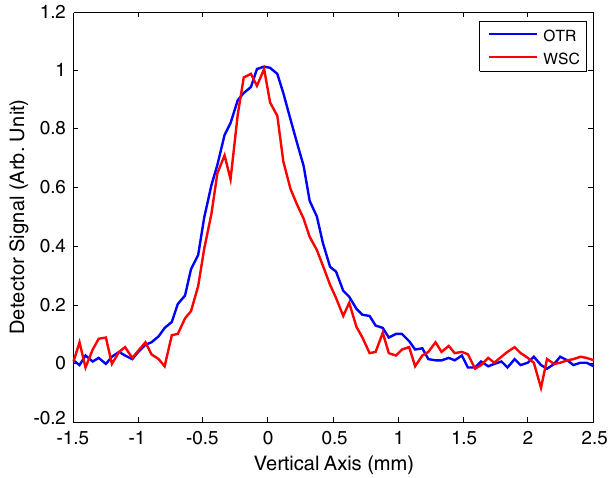
FIG. 11. Beam profile of a 10 pC beam — and energy 200 MeV — scanned by a 5 μ m tungsten wire as reconstructed by the signal readout of (a) BLM1 and (b) BLM2 at a distance of 0.6 and 2.3 m from the WSC,